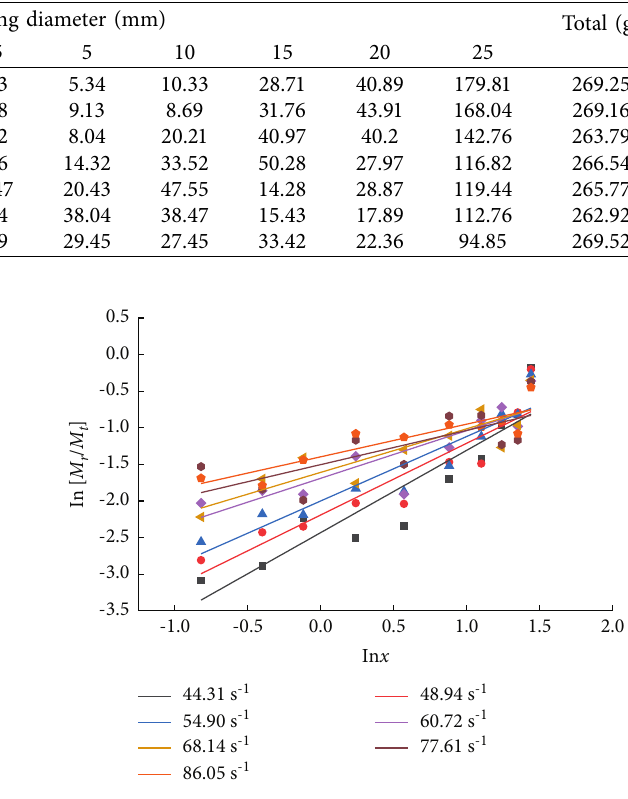
Figure 7: Grain size characteristic curve of dolomite